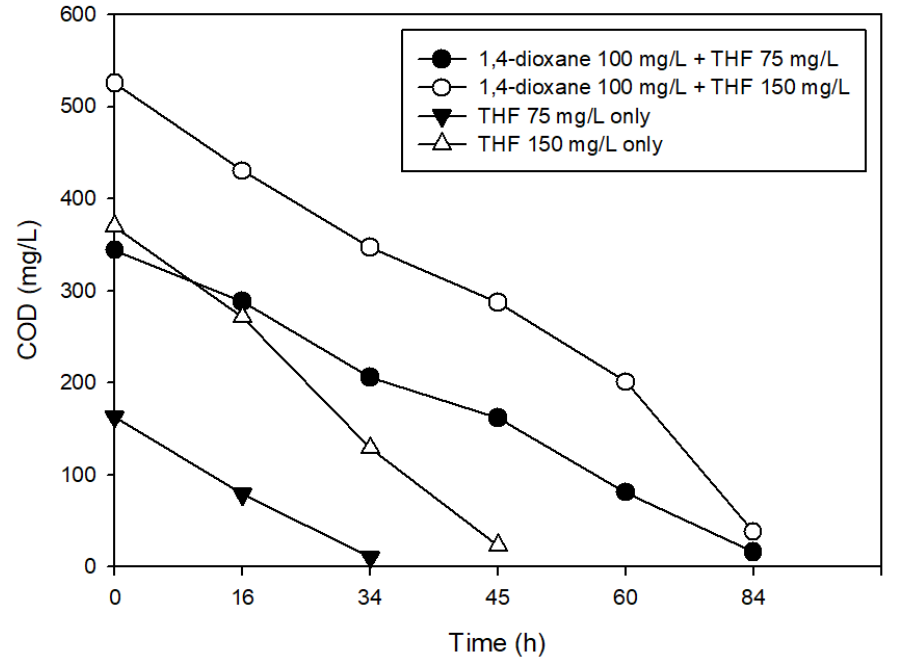
Figure 7. Biodegradation of tetrahydrofuran (THF) by the mixed culture.